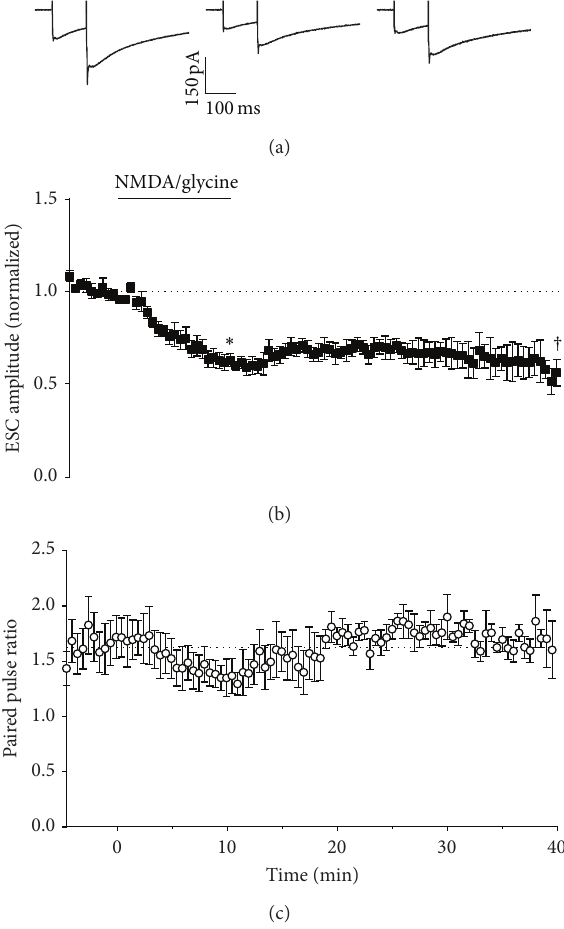
Figure 8: Effect of activation of NMDA receptors on Purkinje neu- ron responses. (a) Representative whole-cell recordings of EPSCs generated by paired pulse stimulation (100ms interval) of parallel fibres in transverse cerebellar slices at 0.033 Hz before (first panel), after 10 minutes incubation with 30 𝜇 M NMDA and 10 𝜇 M glycine (second panel), and after 30 minutes of washout (third panel). (b) Timecourseof 30 𝜇 MNMDAand 10 𝜇 Mglycine effect on amplitude of the first pulse in each pair, with NMDA and glycine incubation at the time indicated by the bar. Data are mean ± s.e.m. from 5 cells. ∗ 𝑃 = 0.0027 , one-sample 𝑡 -test. (c) Time course of 30 𝜇 M NMDA and 10 𝜇 M glycine effect on paired pulse ratio, with NMDA and glycine incubation at the time indicated by the bar. Data are mean ± s.e.m. from 5 cells.